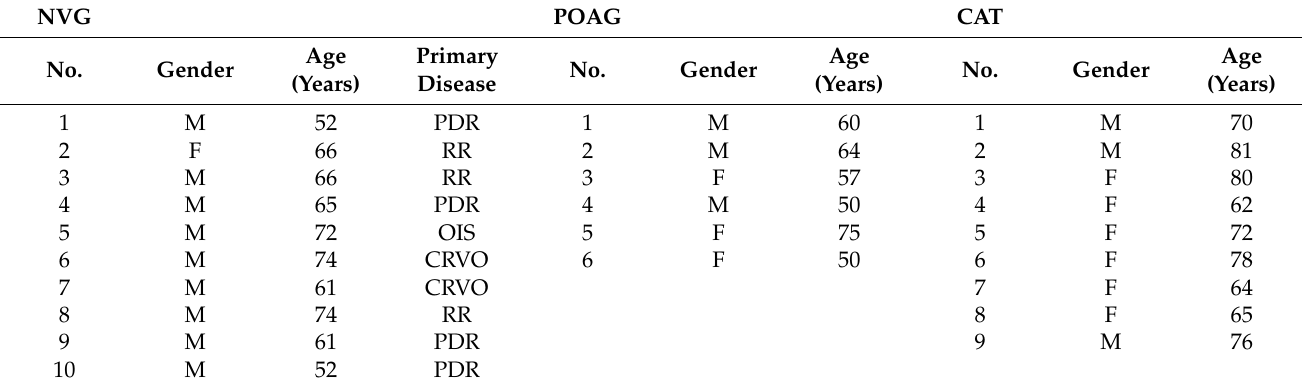
Table 1. Patients’ demographics for vascular endothelial growth factor (VEGF)-C concentrations in the aqueous humor. NVG